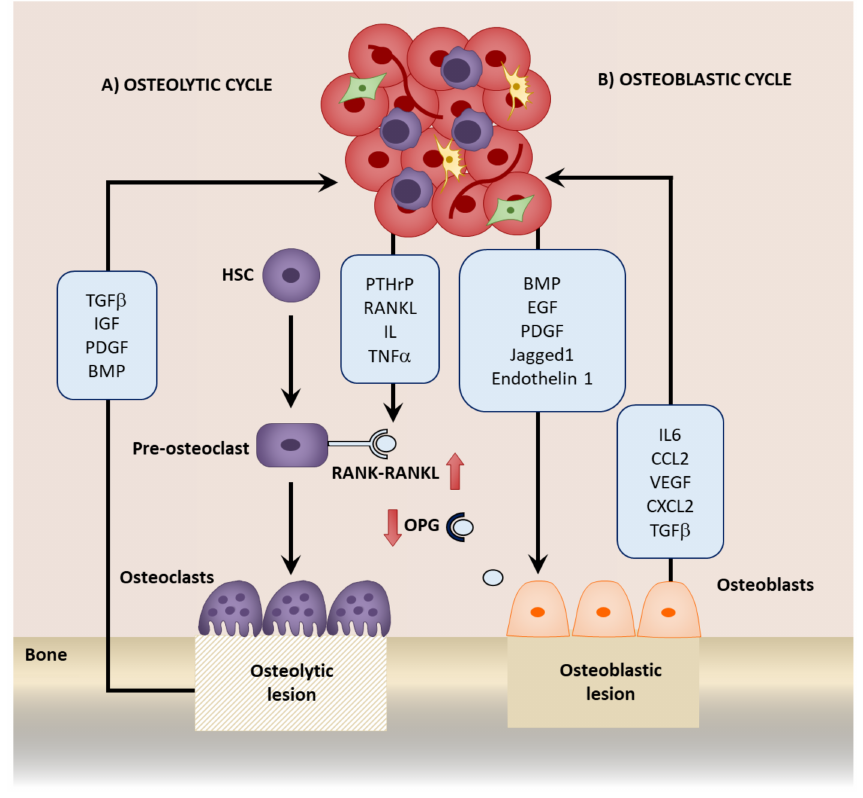
Figure 3. Disruption of bone turnover in an ( A ) osteolytic and ( B ) osteoblastic bone metastasis, and growth factors involved